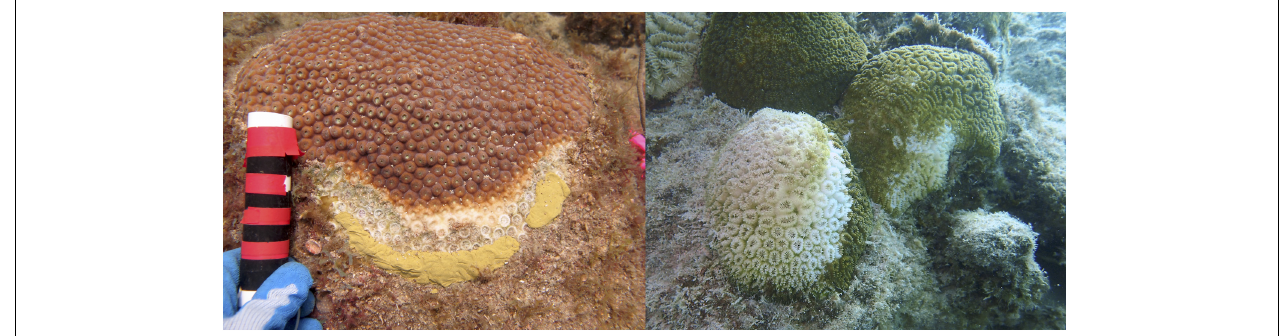
FIGURE 1 | Representative pictures showing Montastraea cavernosa with a subacute tissue loss lesion on the left and Dichocoenia stokesii with acute tissue loss lesions on the right